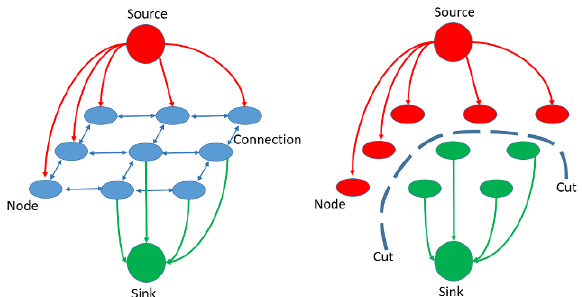
Figure 1. A representation of a graph (left) and the resulting cut (right), Figure taken with adaptation from (Boykov Y., and Funka-Lea G., 2006)